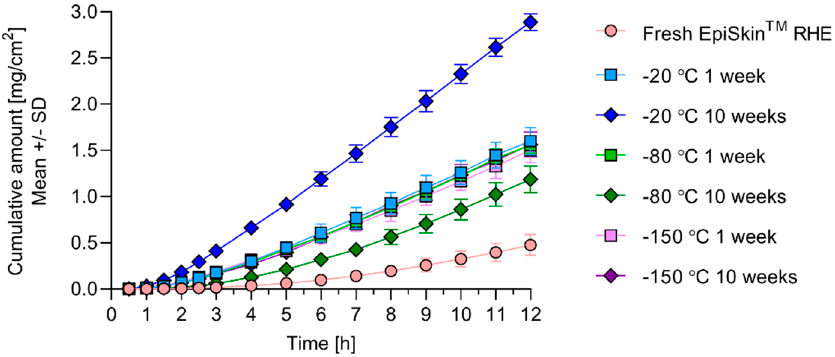
™ RHE. ◦ C for 1 week,